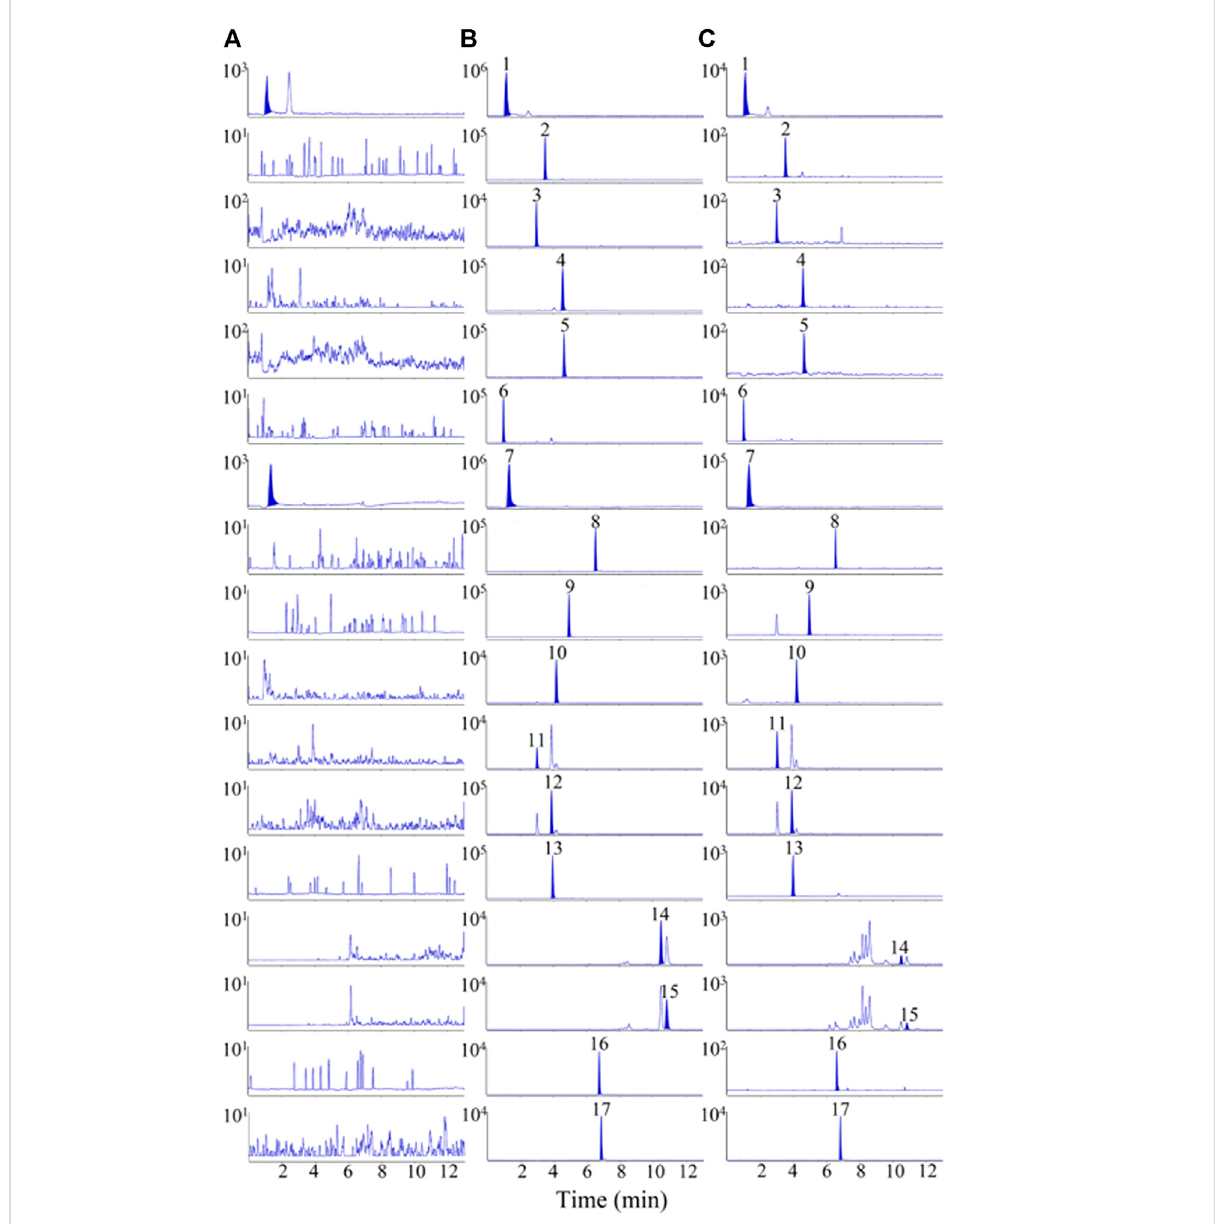
FIGURE 2 Representative multiple reaction monitoring (MRM) chromatograms of 16 analytes and IS in rat plasma samples. (A) blank plasma sample, (B) blank plasma spiked with 16 analytes and IS, (C) plasma samples after oral administration of MF extract. 1. L-(-)-malic acid, 2.3,4- Dihydroxybenzaldehyde, 3. Protocatechuic acid, 4. Vanillic acid, 5. caffeic acid, 6. D-(-)-quinic acid, 7. citric acid, 8. ferulic acid, 9. syringic acid, 10. cryptochlorogenic acid, 11. neochlorogenic acid, 12. chlorogenic acid, 13. amygdalin, 14. maslinic acid, 15. corosolic acid, 16. rutin, 17. rosmarinic acid